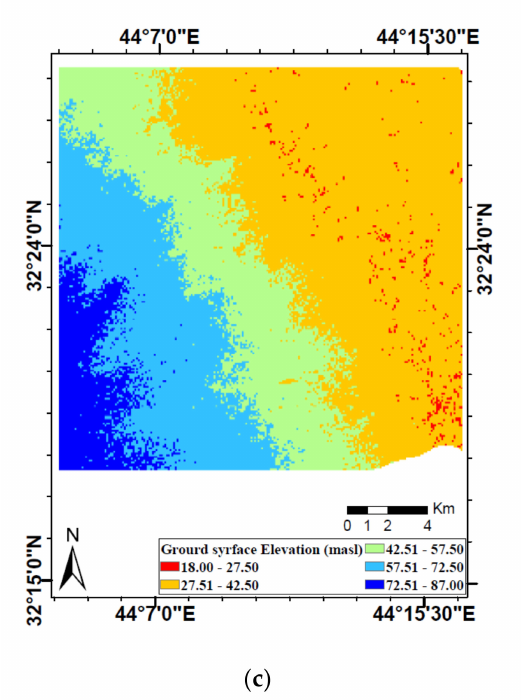
Figure 4. Dibdibba study area, ( a ) geomography; ( b ) section A-A in Figure 4a above, ( c ) ground surface elevation (m.a.s.l.); a and b modified after